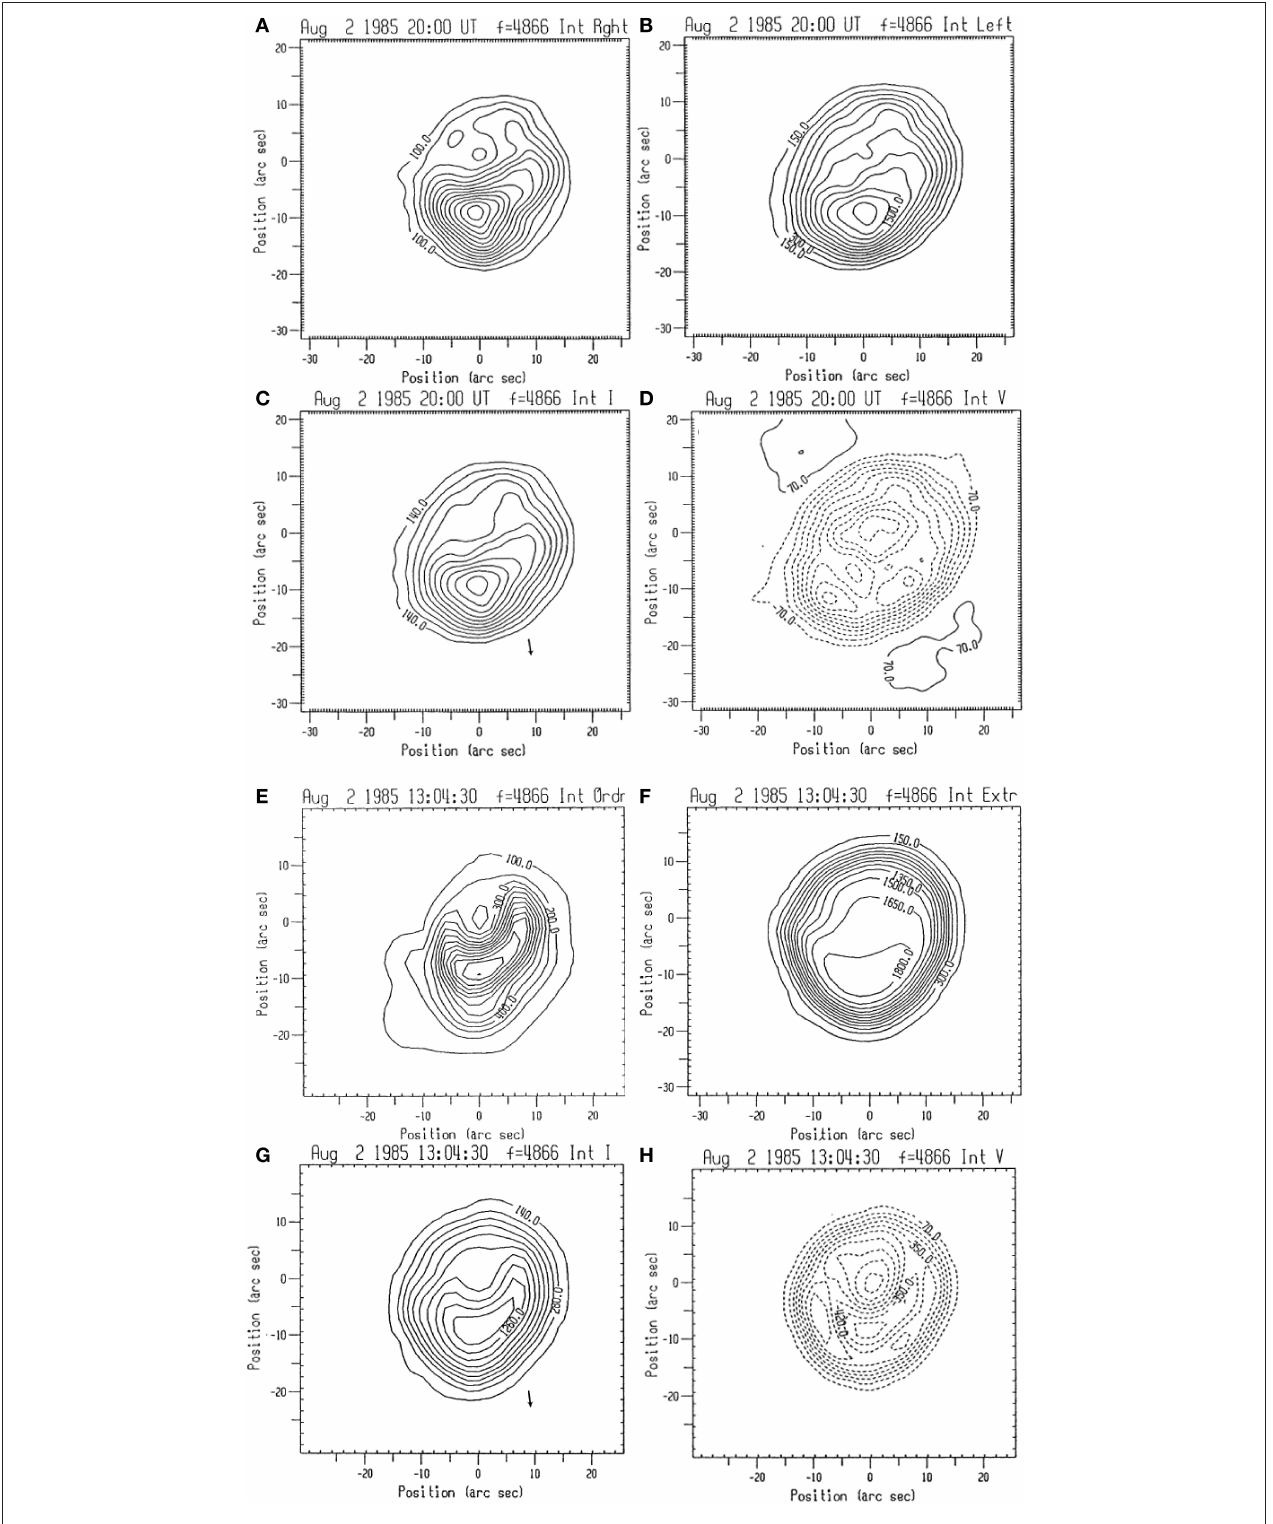
FIGURE 10 | Maps of active region 4862 observed with the VLA at 5 GHz in Stokes I , V ( C,D , respectively) and in R and L polarization ( A,B , respectively). The contours are in brightness temperature steps of 1.4 show models of active region 4862 at 5 GHz in R and L which were computed with α show model I and V maps, respectively, calculated from the models of panels (E,F) . The arrow in panels (C,G) shows the direction of the limb (adapted from Nindos et al., 1996). Reproduced with permission © Springer